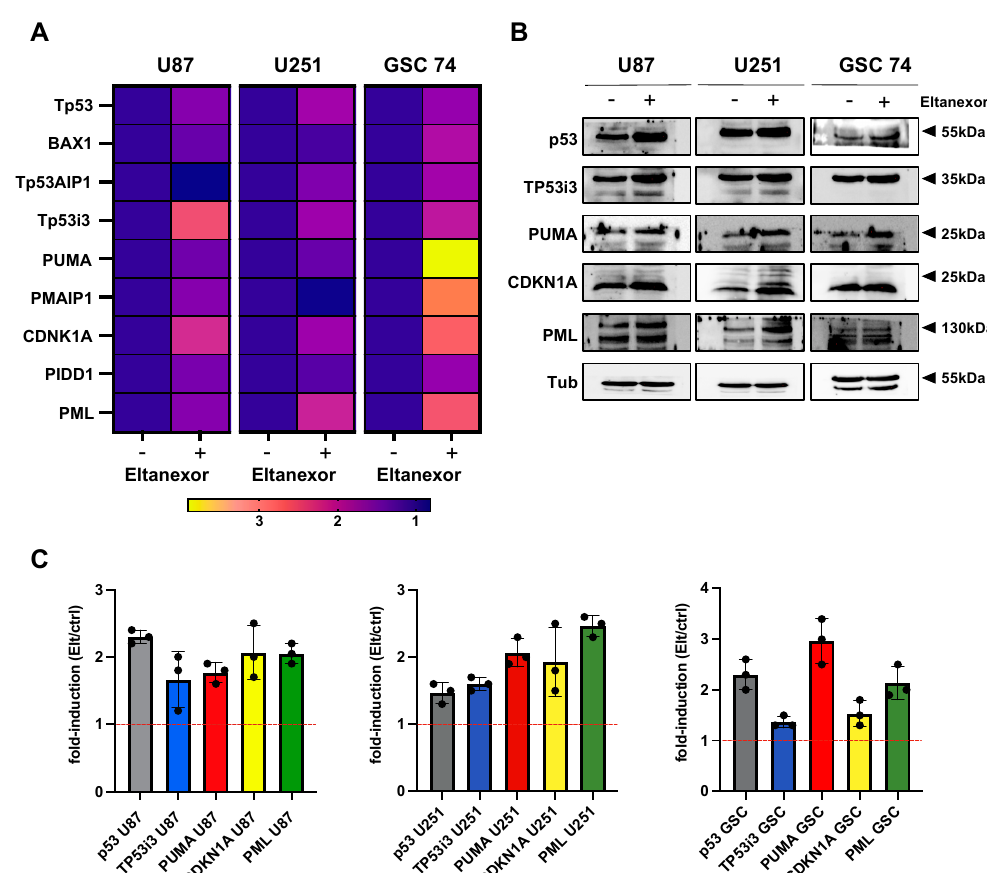
Figure 3. ( A ) Changes in gene expression induced by 100 nM Eltanexor (indicated by “+”) or the corresponding volume of vehicle (DMSO) treated for 24 h in U87, U251, and GSC 74 cells. All values are shown as color codes and are based on triplicate measurements performed in three independent experiments. All expression levels are shown relative to the control condition (“Eltanexor”, set to 1) with relative changes given. ( B ) representative images from western blot for induction of proteins p53, Tp53i3, PUMA, CDKN1A, and PML after treatment of U87, U251, and GCS74 cells with Eltanexor (100 nM) for 24 (U87, U251) and 48 (GSC74) hours. ( C ) quantification of immunoblots based on three independent replicates relative to the control condition (set to 1, red dotted